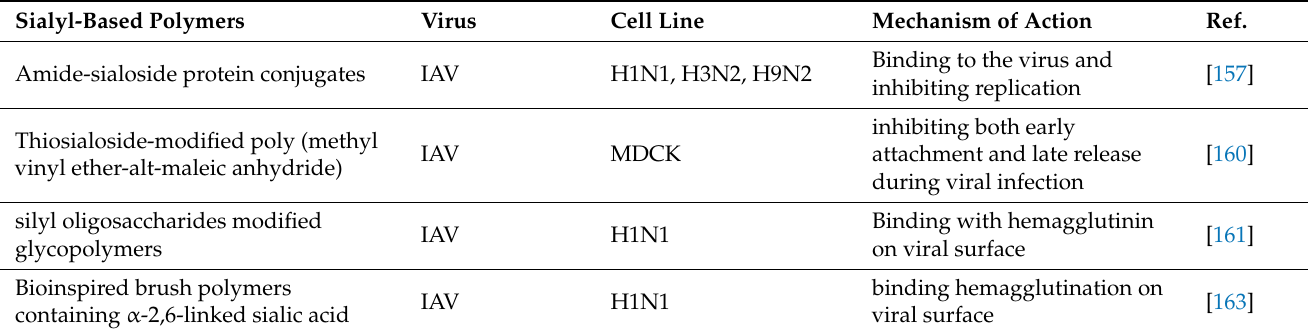
Table 7. List of studies on antiviral activity of sialyl-based polymers with their mechanism of action. Sialyl-Based Polymers Virus Cell Line Mechanism of Action